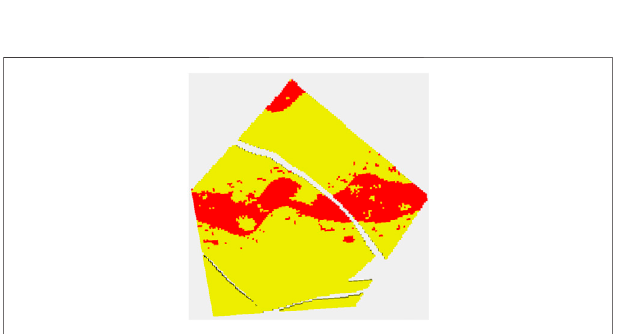
FIGURE 7 | Red are locations when the true porosity is above